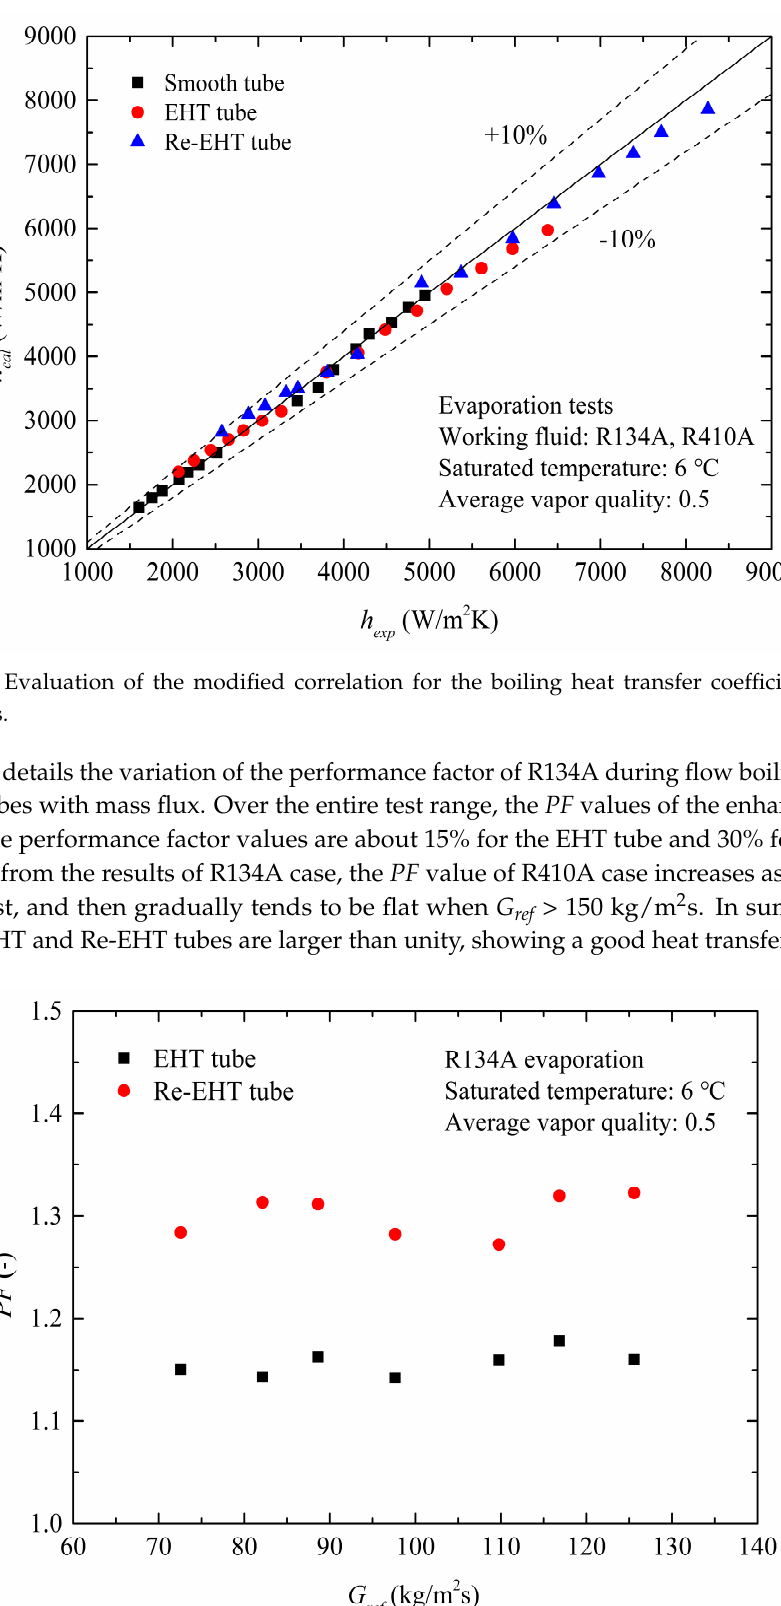
 Table 7. Prediction accuracy of the heat transfer correlations. Correlations